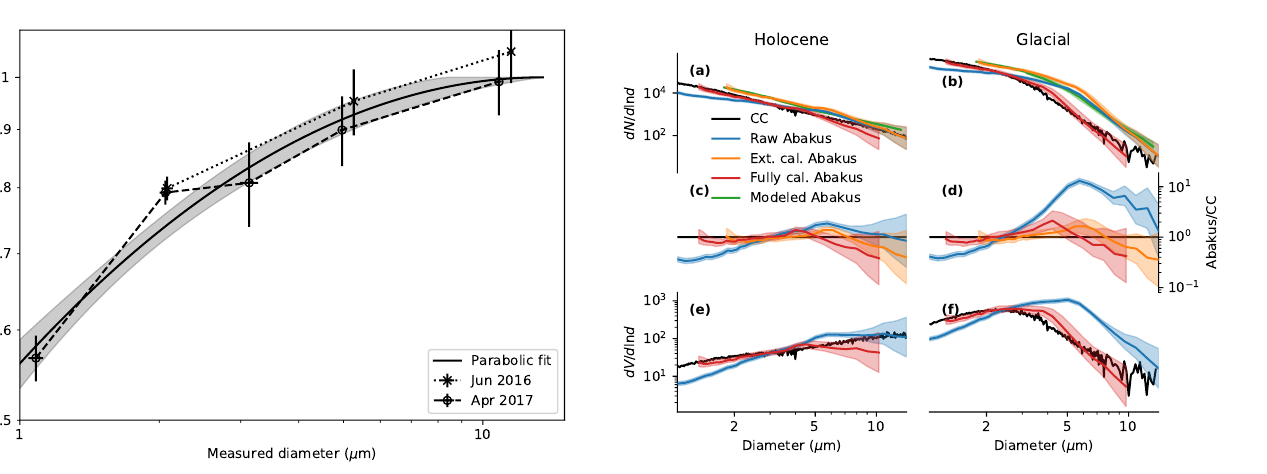
Figure 4. The ratio between the diameter of spheres measured by the Abakus in April 2017 and their extinction diameter (Fig. 2) (cir- cles and dashed line), together with three of the same standards measured a year earlier (crosses and dotted line) and a fit to the log- arithm of the April 2017 data (solid line). The fitted parameters are ( a,x 0 ) = ( − 0 . 086 , 2 . 60) of the function a ( x − x 0 ) 2 , where x is the logarithm of the diameter in µm. The uncertainty on the fit (shading) is based on the uncertainty in the data points.